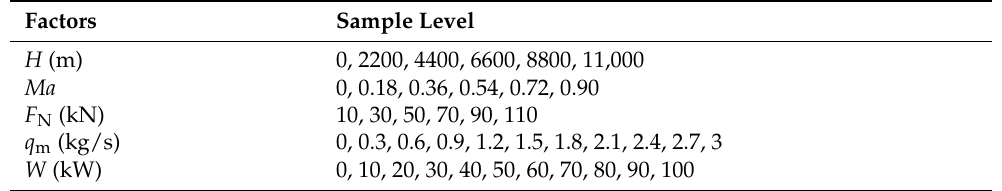
Table 3. Sample distribution.